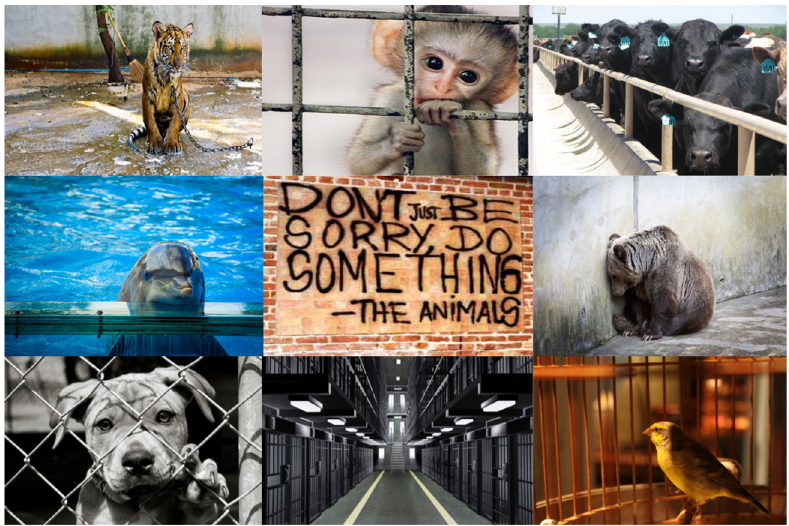
Figure 2. Contemplating Animal Captivity and Freedom (Source: Collage by Louis Komjathy).